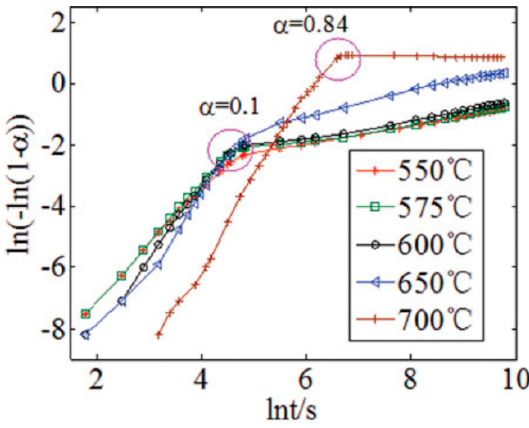
Figure 7. Fit of kinetic experimental data by the Avrami–Erofeev model [27].